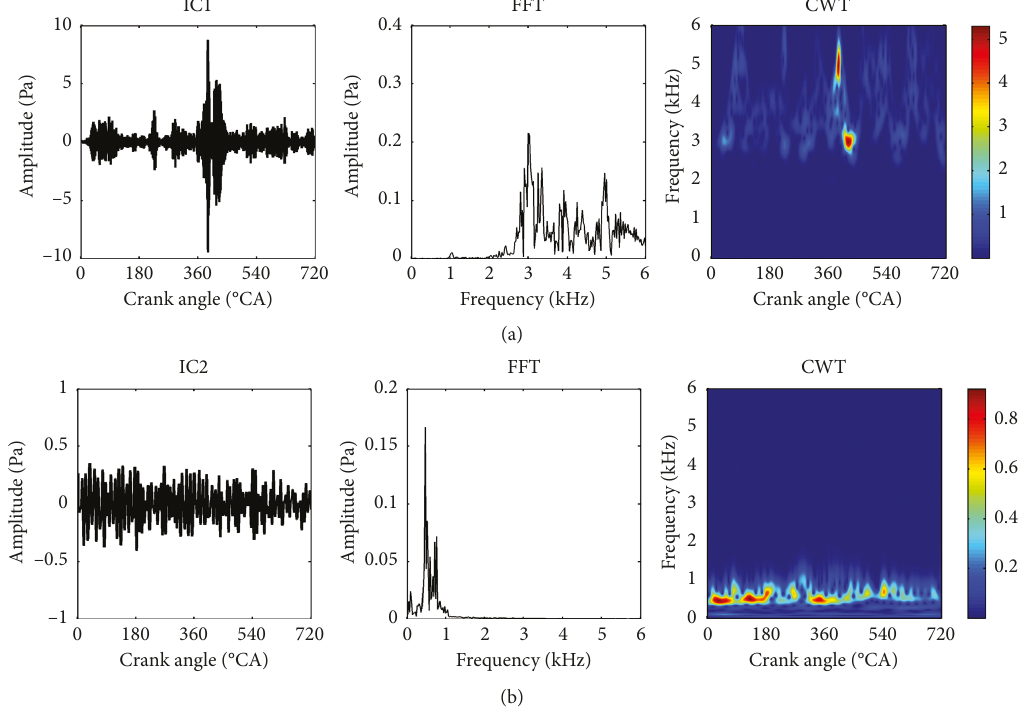
Figure 15: Time-domain waveform, spectrum, and time-frequency diagram of (a) IC1 and (b) IC2 from main slap side noise signal y